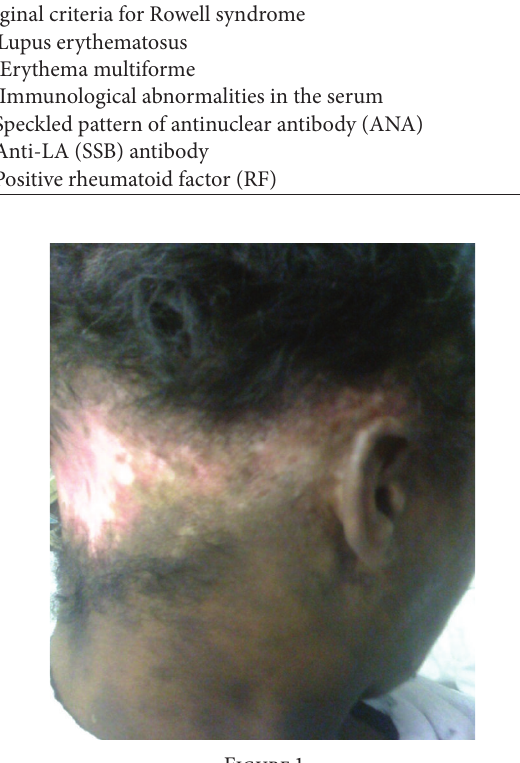
Original criteria for Rowell